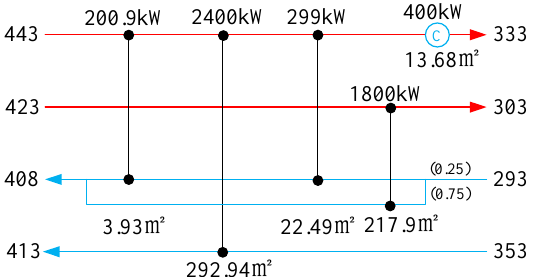
cost (TAC) is 77,958 $/a.